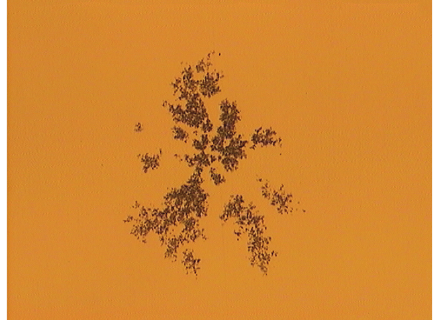
Figure 7: 200x magnification of Eta-phase on sample B.